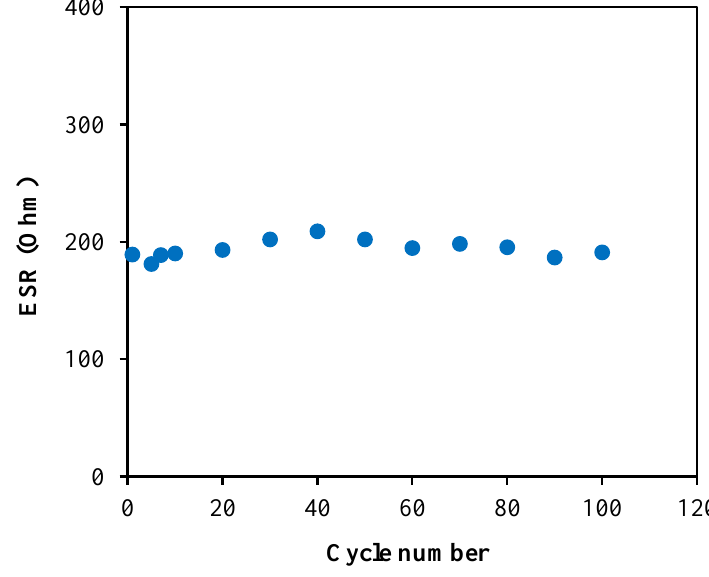
Figure 12. Equivalent series resistance, ESR of the fabricated EDLC.